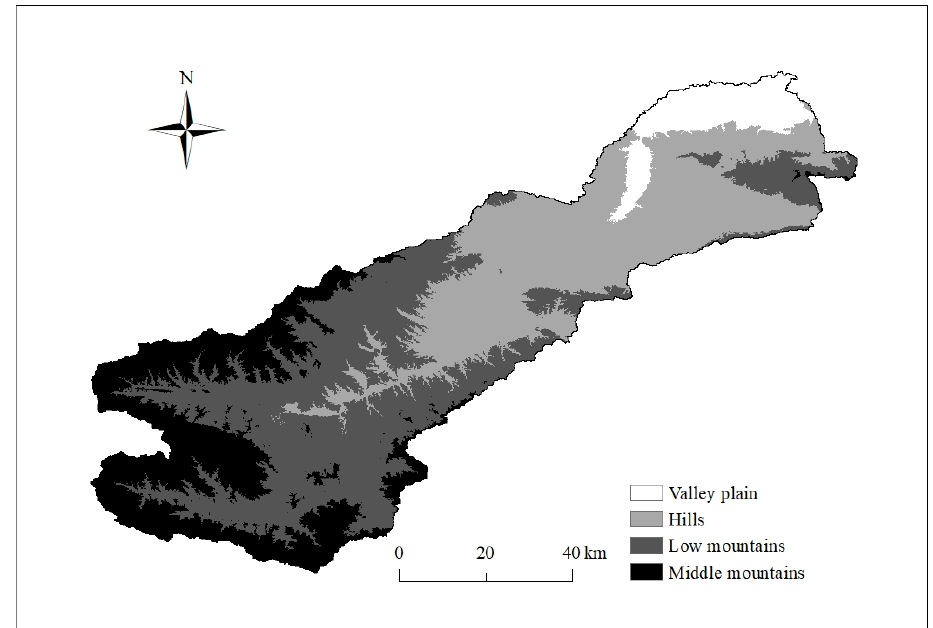
Figure 2. Landform classification of the Yi River basin.